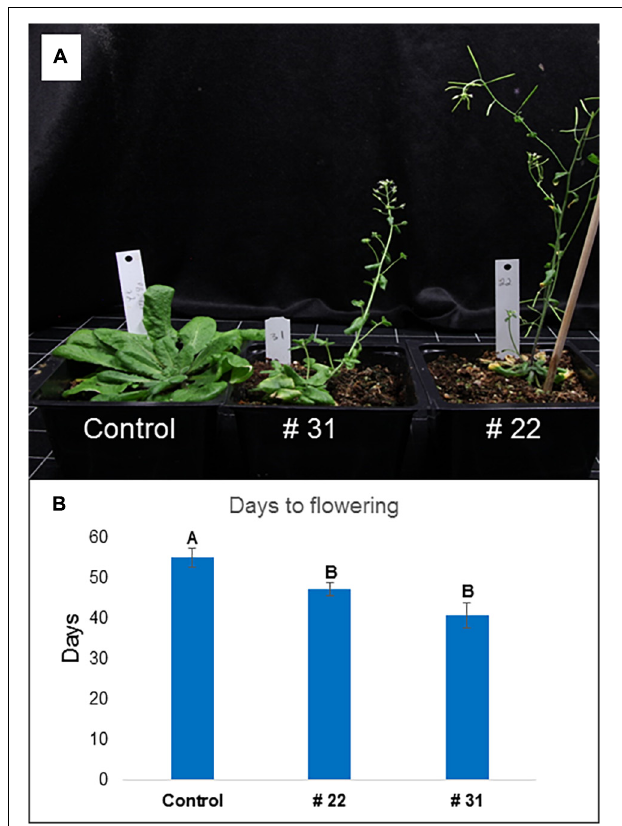
FIGURE 8 | Arabidopsis transformants with PgPolyQ-MADS and control. Three representative transformant plants: Control plant transformed with PBI121, #31 and #22 plants transformed with PgPolyQ-MADS . (A) 45 days after sawing, #31 and #22 show a distinctive phenotype of smaller plants with few rolled leaves and early flowering. Days to flowering from sawing (B) , average ± standard error, letters represent significant differences by comparisons for each pair using Student’s t test.